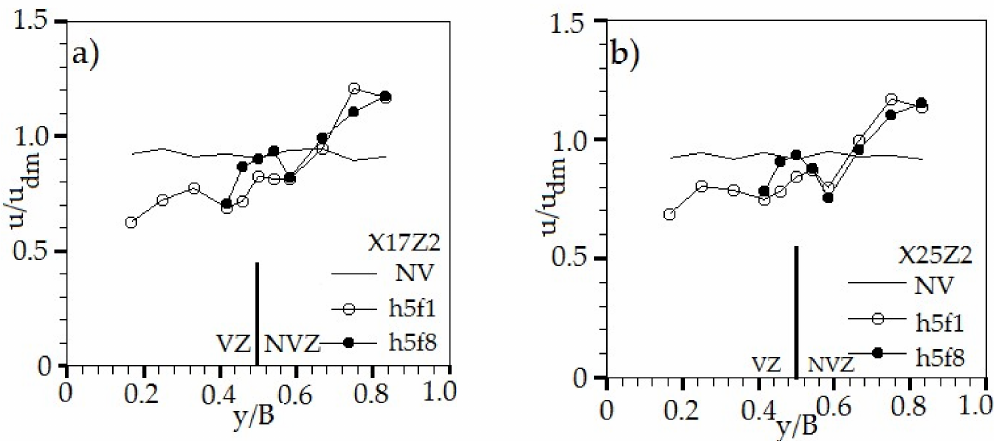
Figure 9. Non-dimensional streamwise velocity distributions along the spanwise direction at z / h v = 0.5 for h v = 0.05 m and different SVFs; ( a ) X17; ( b ) X25.